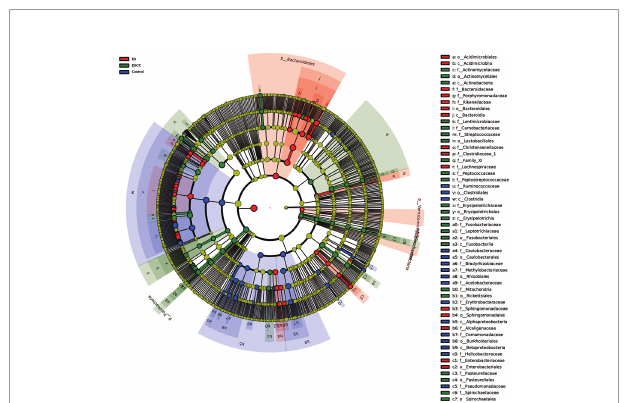
FIGURE 3 | Linear discriminant analysis effect size (LEfSe) analysis showed the most abundant taxa from the phylum to the genus level among the control, esophagitis (ES), and esophageal squamous cell carcinoma (ESCC)